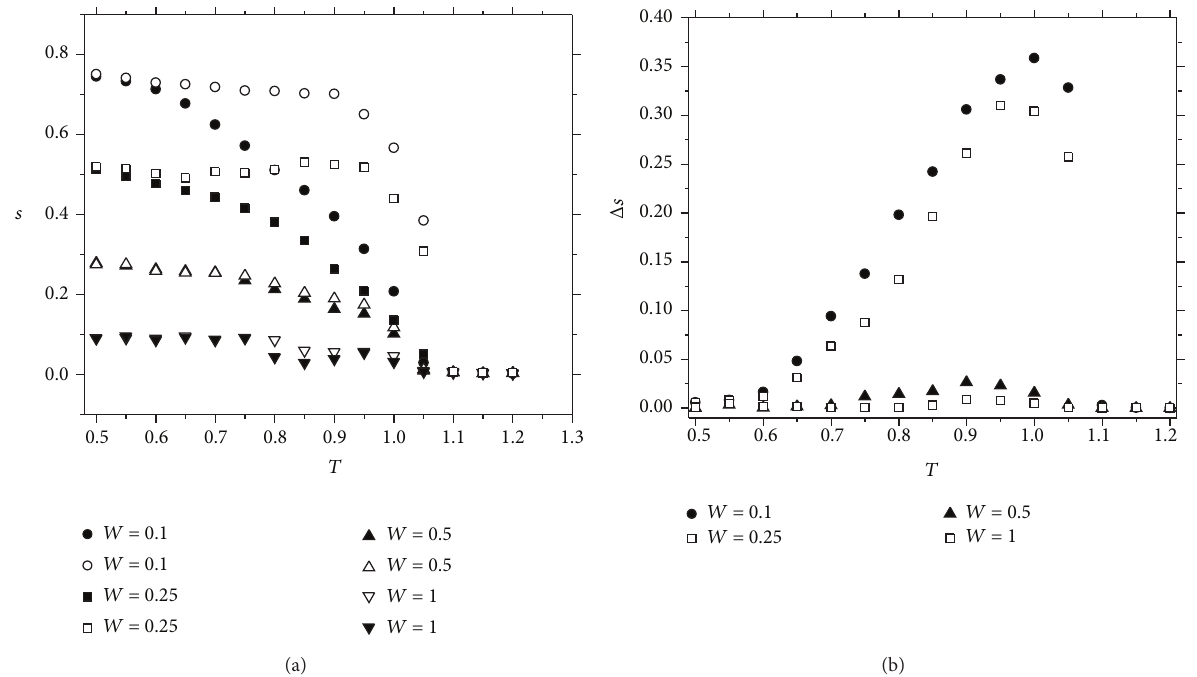
Figure 1: Temperature evolution of the degree of nematic ordering on decreasing and decreasing temperature. (a) 𝑠(𝑇) and (b) Δ𝑠 = 𝑠 ( up ) − 𝑠 ( down ) , where 𝑠 ( up ) and 𝑠 ( down ) refer to nematic ordering obtained on increasing and decreasing temperature, respectively. 𝑝 = 0.1 and 𝑁 = 70 .